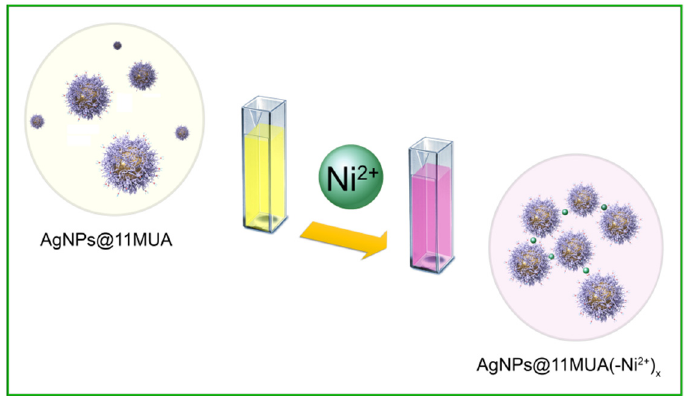
Figure 12. Schematic clustering process in the in the interaction of Ni 2+ ions with AgNPs@11MUA. Given the sigmoidal shape of the titration curve, the interaction of AgNPs@11MUA with Ni 2+ can be considered a random-like process that is regulated by apparent coop- erativity, i.e., the binding of the first Ni 2+ ion to the AgNPs@11MUA is associated with a structural modification that results in a more favorable binding of subsequent ones. Specifi- cally, the increase in Ni 2+ concentration is associated with higher clustering rate, faster appearance, and increase in intensity of the second SPAB, and consequent faster response of the sensor. Conversely, the increasing steric hindrance and the critical size of NPs-Ni 2+ clusters represent the limiting factors of the sensor. Therefore, by adapting Hill’s equation [55] to our system, it was possible to obtain quantitative information on the mechanism of